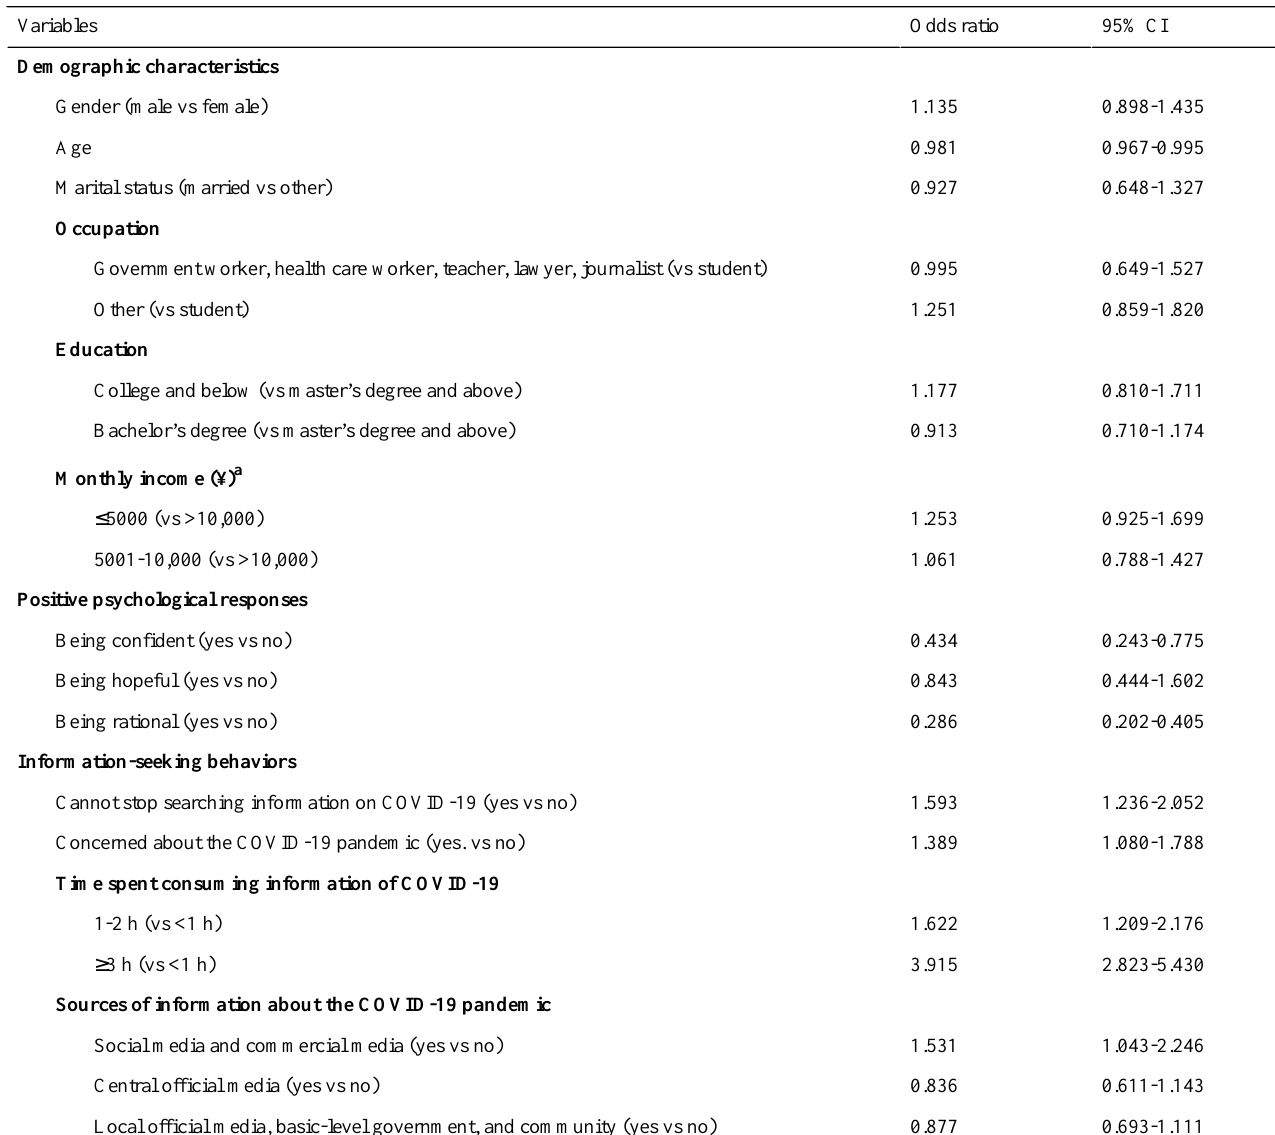
Table 2. Multivariable logistic regression analysis for factors associated with